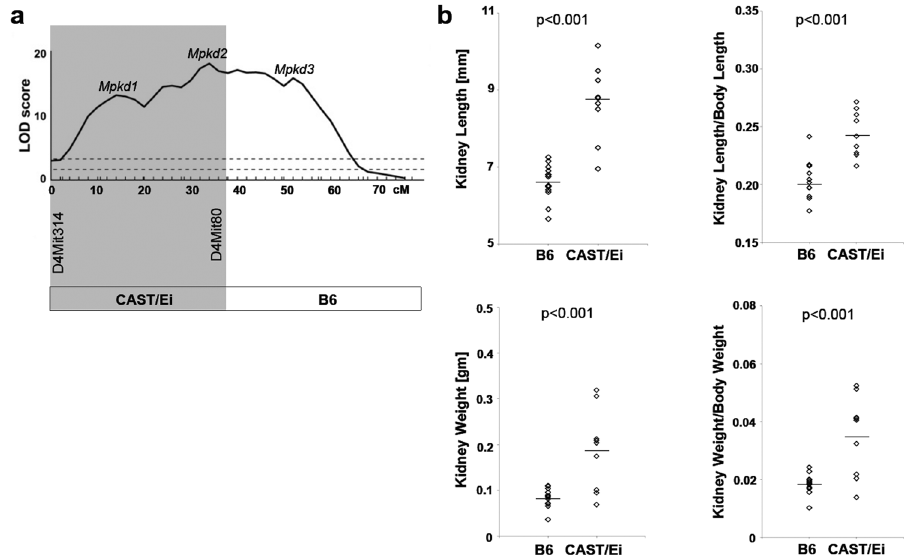
Fig 2. Congenic CAST-derived interval containing the Mpkd1-2 loci and its effects on renal cystic disease progression. a) The CAST-derived segment of Chr 4 corresponding to Mpkd1-2 interval is delimited by the marker, D4Mit80 (shaded area). The breakpoint between the proximal CAST/E-derived and distal B6-derived segment of Chr 4 occurred between markers D4Mit80 (37.7 cM) and D4Mit175 (45.7 cM). b) The predicted cystic disease-modulating effects of the CAST-derived Mpkd1-2 loci was tested by comparing the renal cystic phenotypes in Cys1 cpk/cpk mutants that were heterozygotes for the CAST-derived (CAST/Ei; n = 9) Mpkd1-2 interval to Cys1 cpk/cpk mutants from the same cross that were homozygous B6 for the Mpkd1-2 interval (n = 14). The genetic background of both groups was B6. Diamonds represent values for individual animals. The line indicates the mean value for each group.